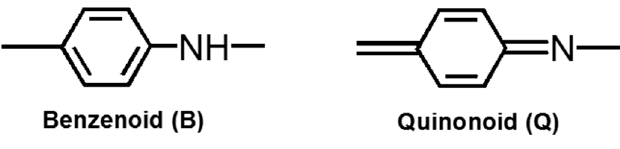
Figure 1. Cont. Figure 1.